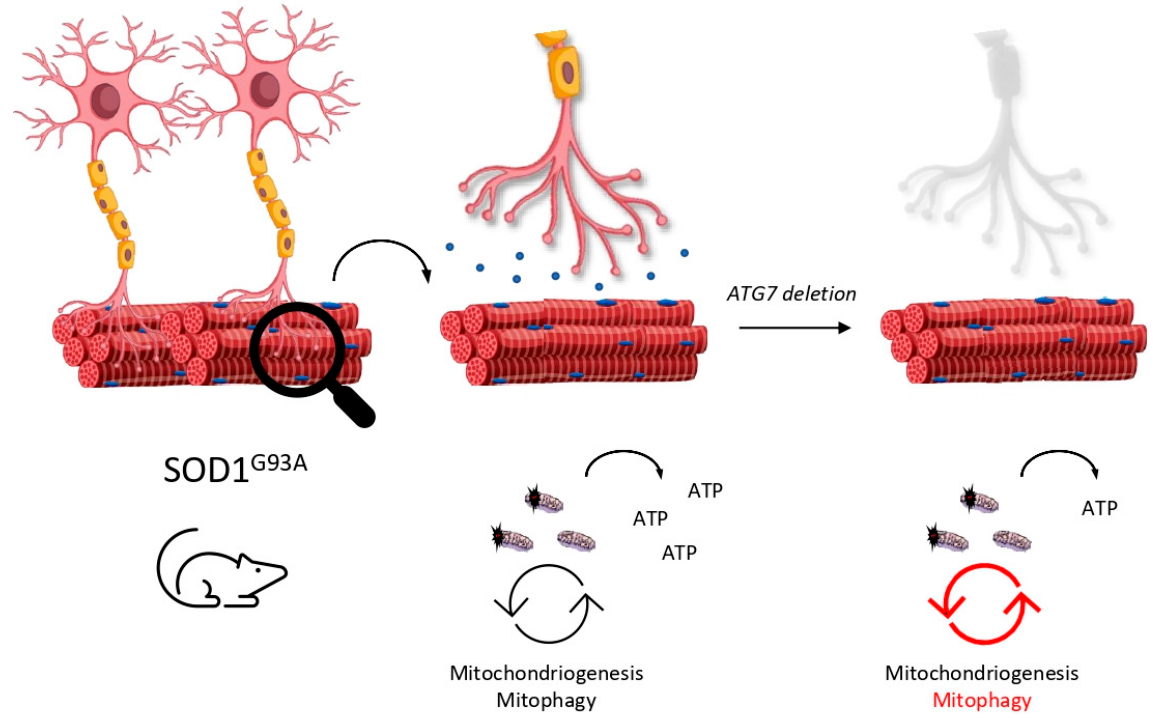
Figure 4. Mitophagy is essential to maintain the neuromuscular junction (NMJ). Inefficient renewal of mitochondria due to the selective deletion of ATG7 in motoneurons may lead to low le-vels of ATP and make them prone to denervation.